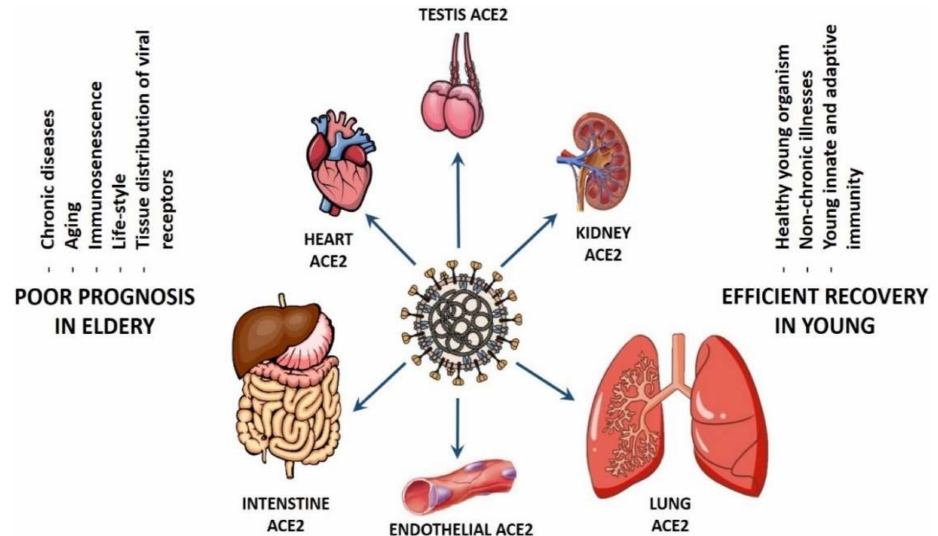
Figure 2. Suggested scenarios for the coronavirus disease 2019 (COVID-19) pathogenicity in old and young